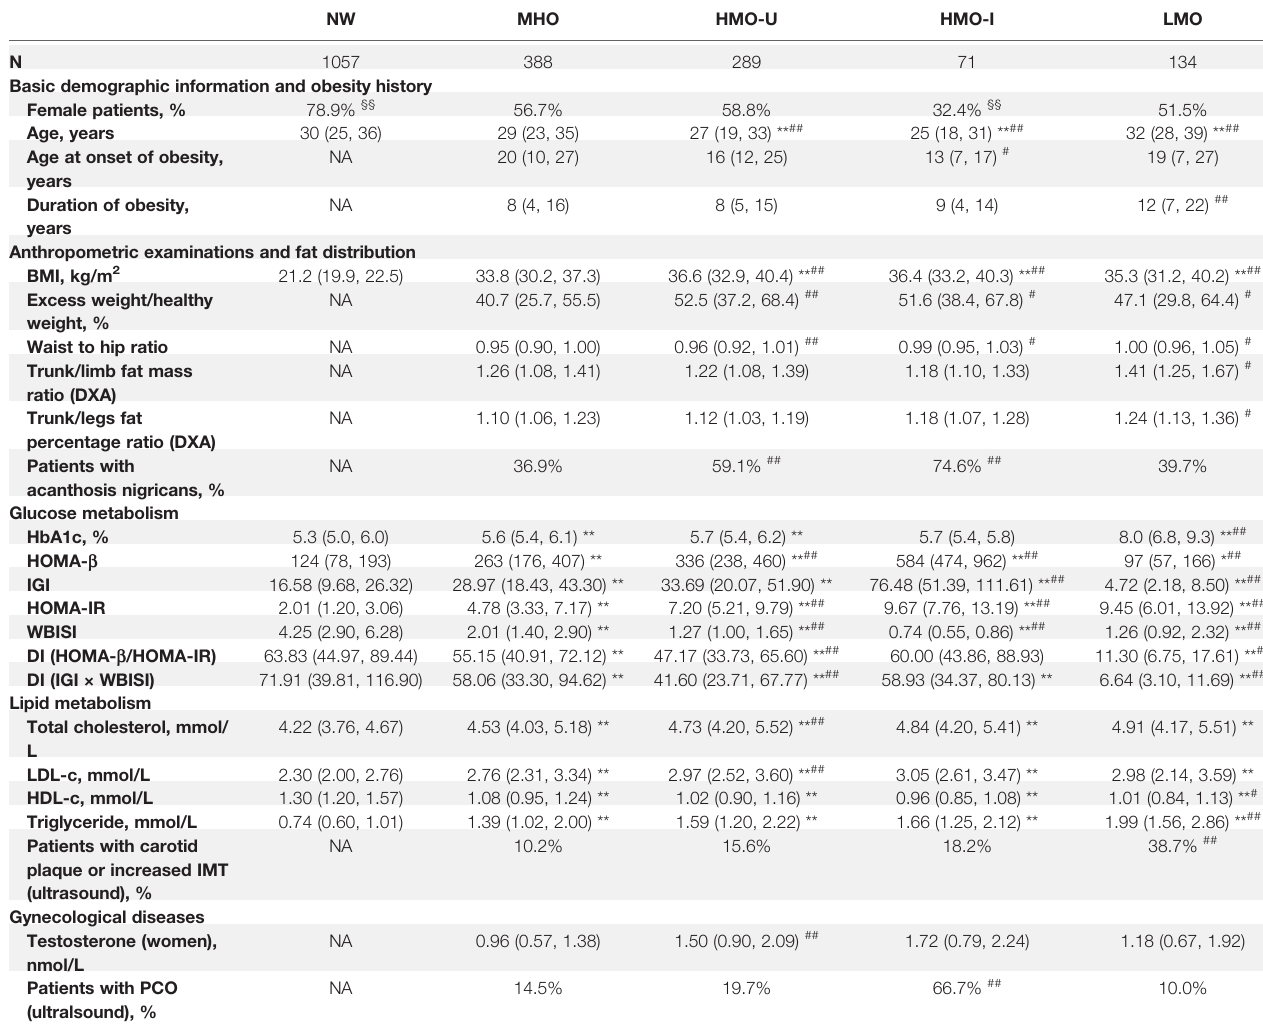
TABLE 4 | Comparison of clinical variables across the four clusters generated from Cohort-1 using k-means and from the normal-weight controls. NW